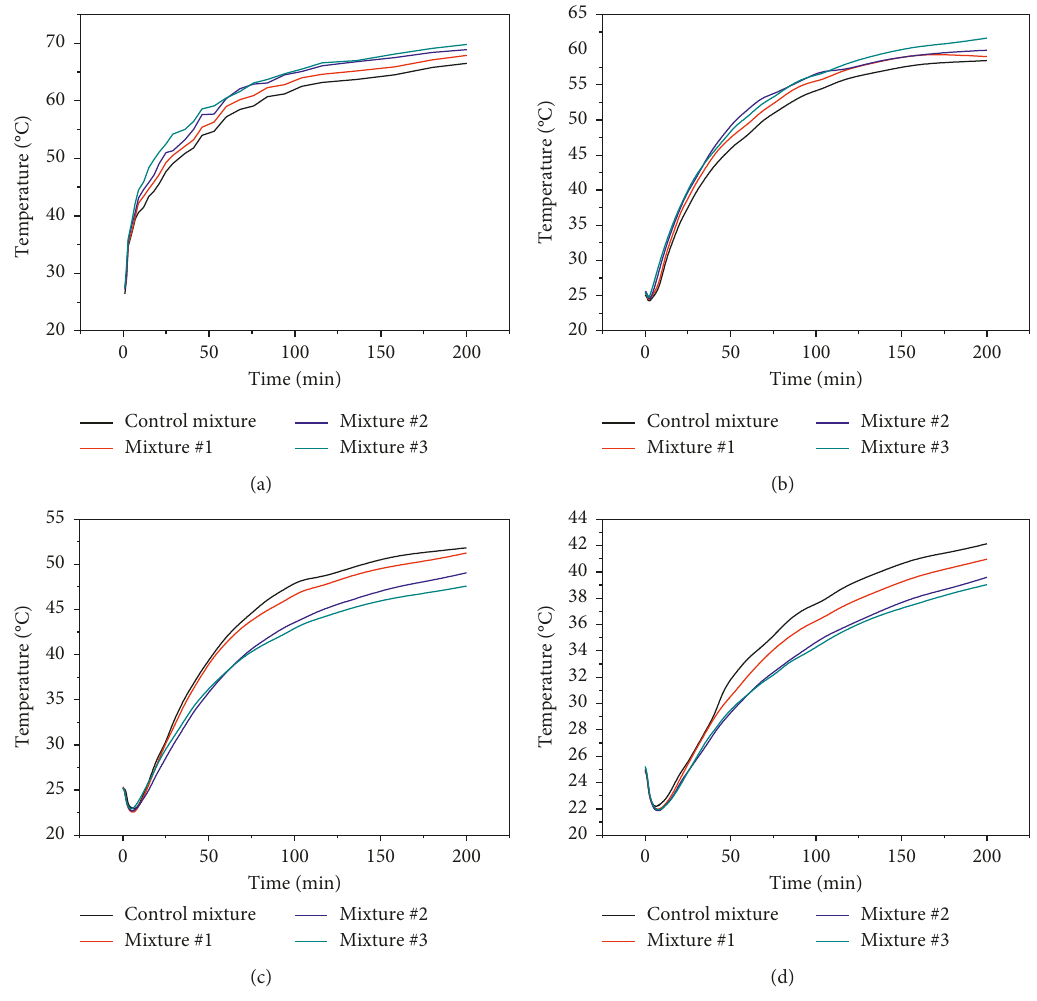
Figure 7: Temperature profiles: (a) upper surface; (b) at the depth of 2cm; (c) at the depth of 4 cm; (d) bottom